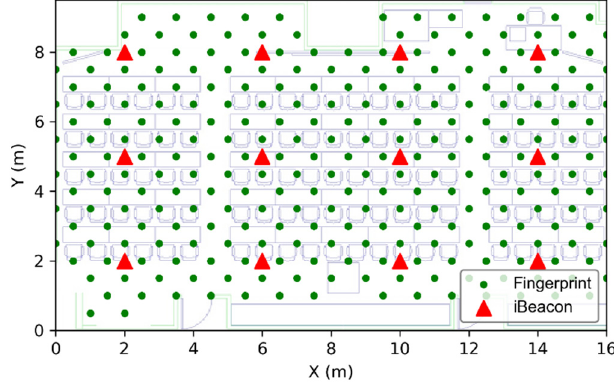
Figure 8. Deployment plan of 12 iBeacons and the locations of fingerprint Figure 8 . Deployment plan of 12 iBeacons and the locations of fingerprint collection.